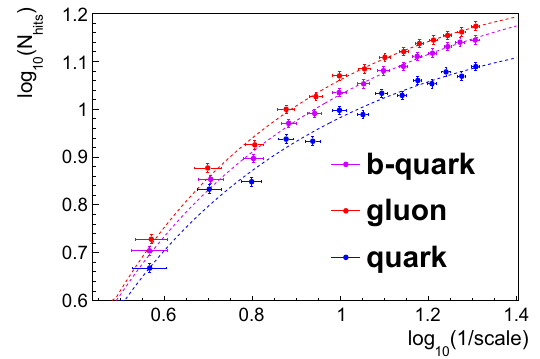
Fig. 2 Left: logarithmic fits to log N hits ((cid:4)) against log ( 1 /(cid:4)) for light quarks,bottomquarks,andgluons,oftheform y = p 0 + p 1 x + p 2 log x . The values of the fitted parameters { p i } define one possible set of